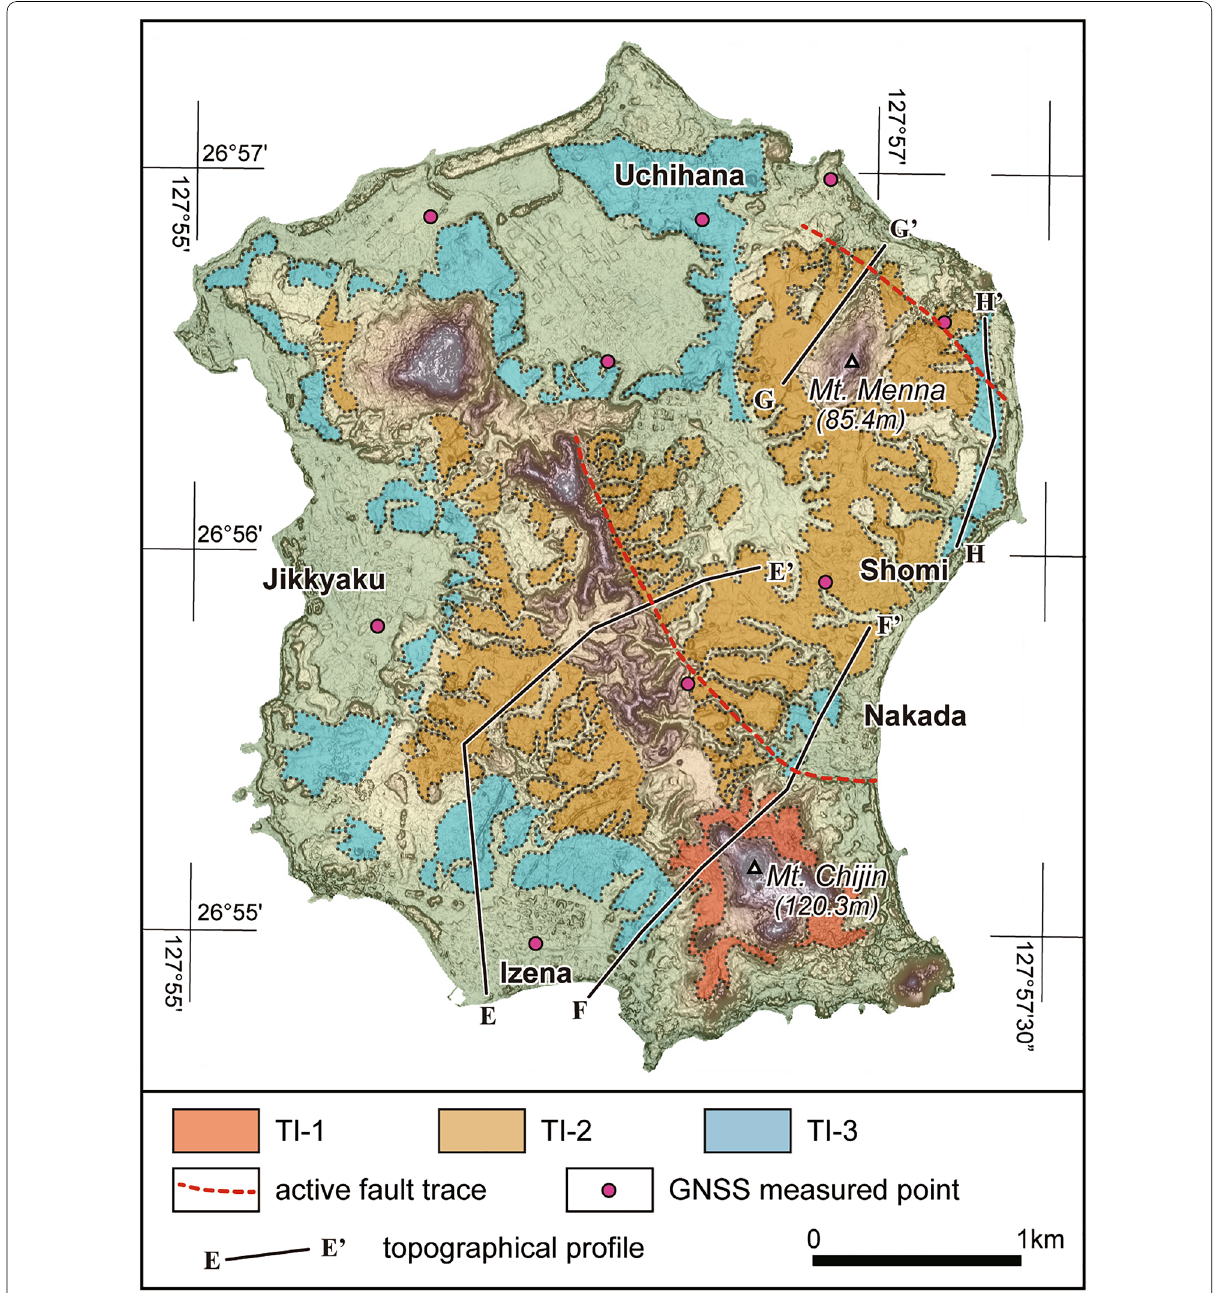
Fig. 3 Distribution of marine terraces and active faults in Izenajima Island. The topographical map is based on the DSM processed from aerial photographs taken in